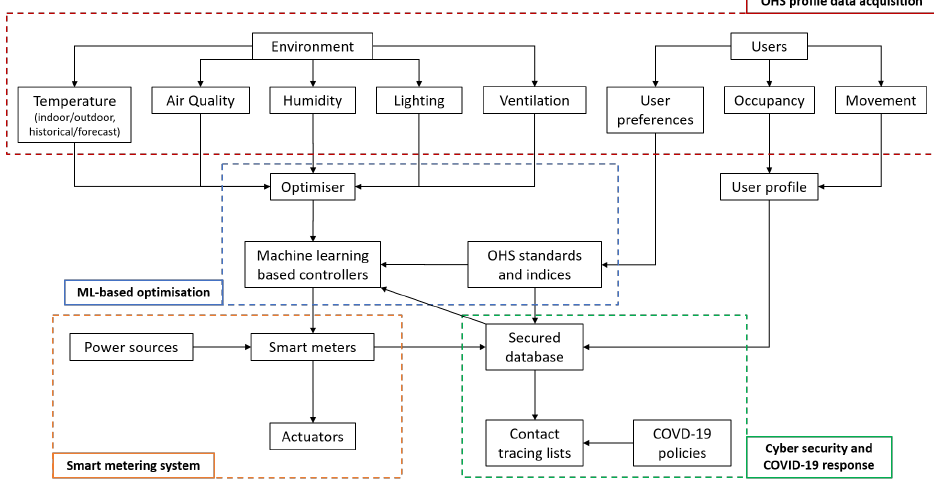
Figure 1. The AI Empowered Cyber Physical Ecosystem (AECPE) solution